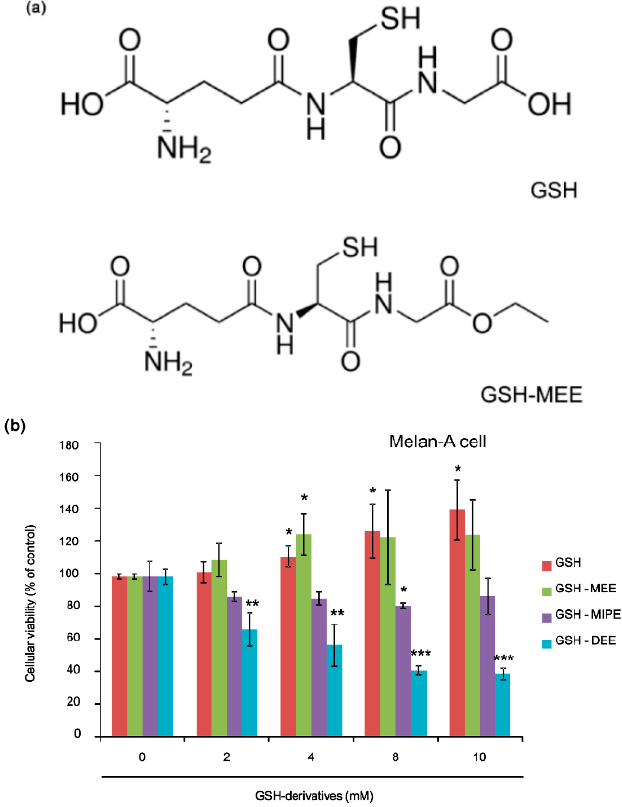
Figure 1. ( a ) Chemical structures of reduced glutathione (GSH) and GSH monoethyl ester (GSH-MEE); ( b ) Effect of GSH derivatives on cellular viability. GSH and GSH-MEE had no effect on cellular viability,